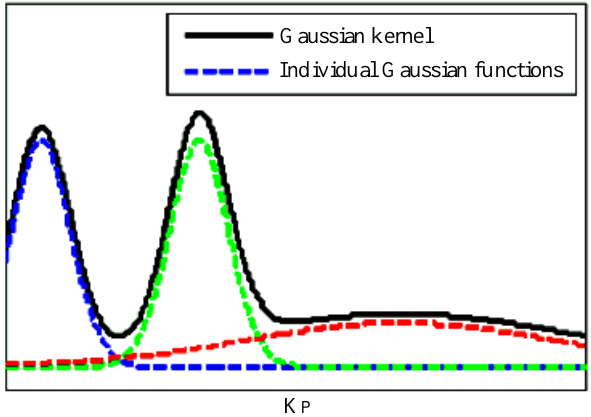
Figure 12. An example of three Gaussian density functions and Gaussian kernel.